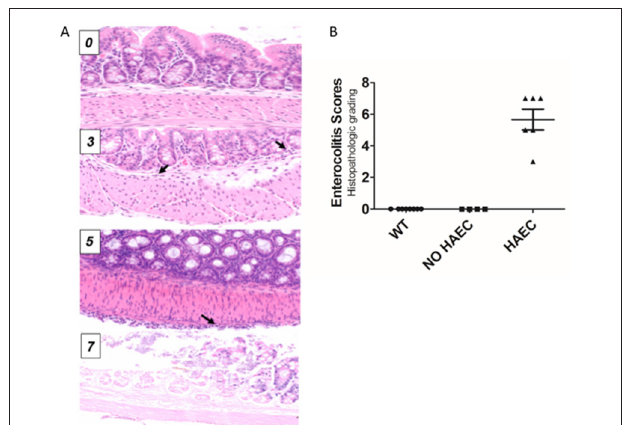
Figure 2 | Histological scores elevated in Ednrb −/− mice with clinical enterocolitis. (a) , examples of histologic enterocolitis scores (H&E stained at 200×) ranging from 0 to 7. Total score 0 (normal); total score 3 (mild inflammatory infiltrate in the submucosa, inflammation 1, depth 2) arrows show neutrophils; total score 5 (mild inflammatory infiltrate at the serosal surface only, inflammation 1, depth 4) arrow show inflammatory cells at the serosal surface; (D) total score 7 (transmural necrosis, depth 4, inflammation 3). (B) , both wild type (WT) and Ednrb −/− NO HAEC groups had total enterocolitis score = 0, consistent with no evidence of clinical enterocolitis. The Ednrb −/− HAEC mice had increased total score 5.67 ± 0.67, indicating severe enterocolitis. N = 8, 4 and 6 for WT, NO HAEC and HAEC, respectively. One-way ANOVA analysis P <